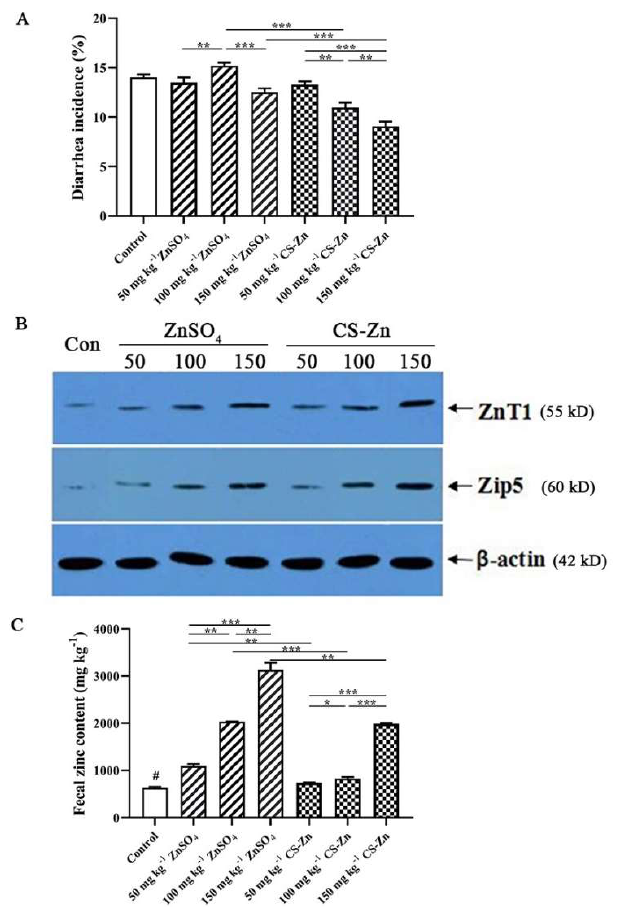
Figure 2. ( A ) Diarrhea incidence of weaned piglets fed dietary CS–Zn or ZnSO 4 . The columns represent means ± SD. ( B ) Intestinal zinc transporters protein expression of weaned piglets fed dietary CS–Zn or ZnSO 4 . The bands are representative blots from one of the six pigs. The relative protein expression was expressed as the ratio of the target protein and β-action. ( C ) The zinc content in feces of weaned piglets fed dietary CS–Zn or ZnSO 4 . The columns represent means ± SD. * Differences were considered significant at p < 0.05. ** Differences were considered significant at p < 0.01. *** Differences were considered significant at p < 0.001. “ # ” Different from all supplemental Zn groups, p < 0.05.